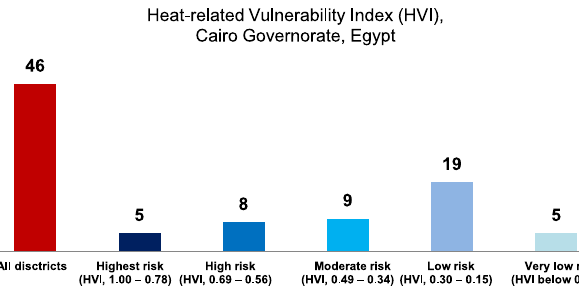
Fig. 11. Map of HVI distribution of the 46 districts in Cairo Governorate, Egypt. Source: